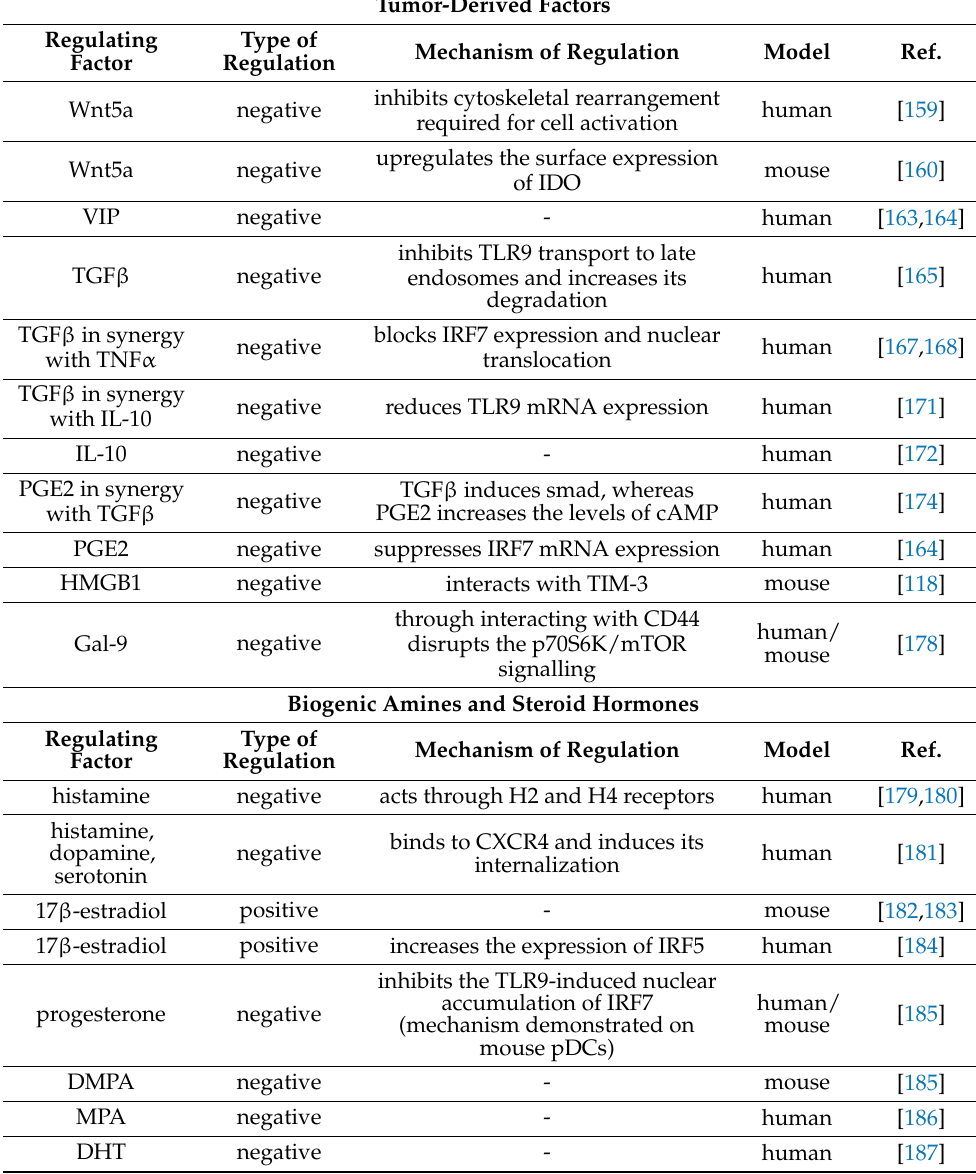
Table 3. Regulation of type I IFN production by extracellular soluble